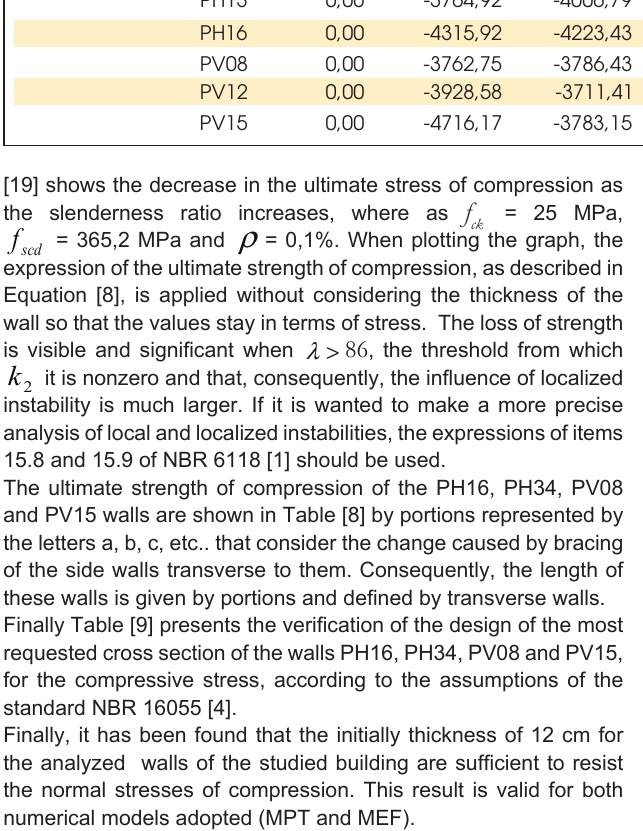
Table 9 – Verification of the design to the maximum normal stress of compression as NBR 16055 [4]